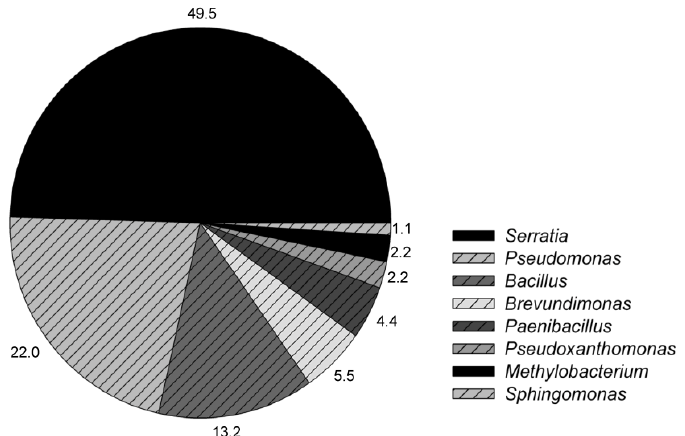
Figure 3. Bacterial groups derived from Dendroctonus armandi 16S rRNA genes ( n =